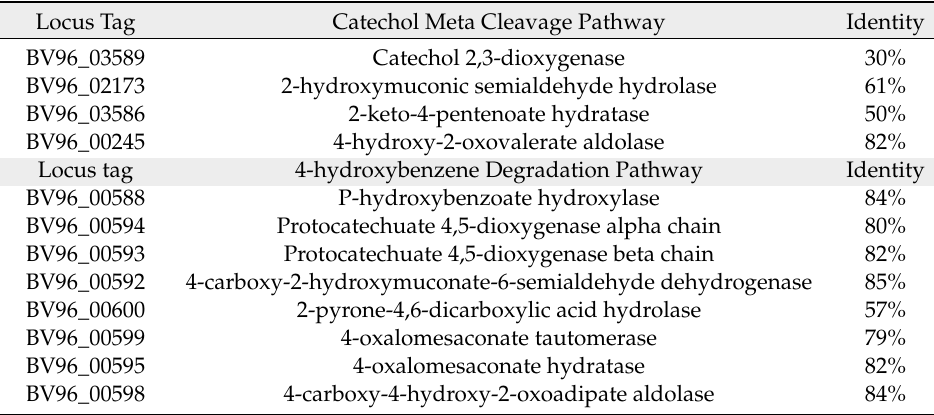
Table 3. PAHs and 4-hydroxybenzene degradation pathway of S. paucimobilis EPA505. Locus